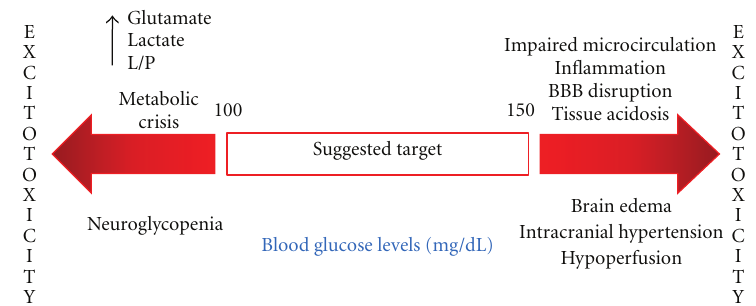
Figure 2: Suggested glycemic targets during acute brain injury/neurosurgery. Where L/P: Lactate/Pyruvate and BBB: Blood–brain barrier.